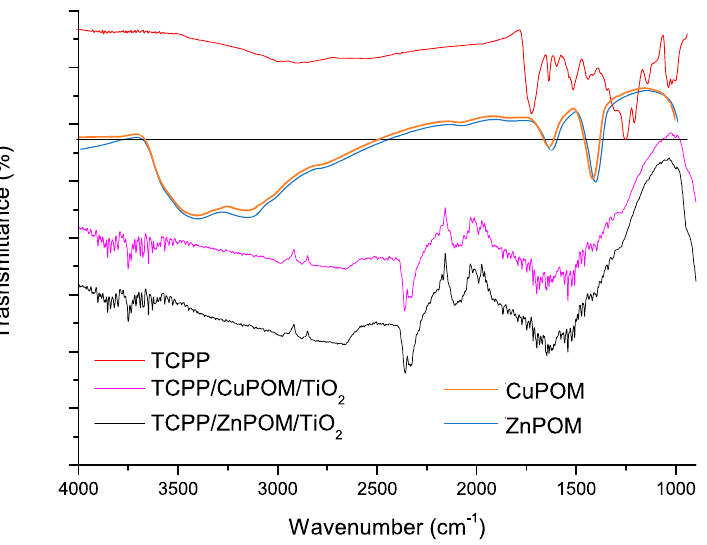
Figure 2. FT-IR spectra of TCPP, CuPOM, ZnPOM, TCPP/CuPOM/TiO 2 and TCPP/ZnPOM/TiO 2 .